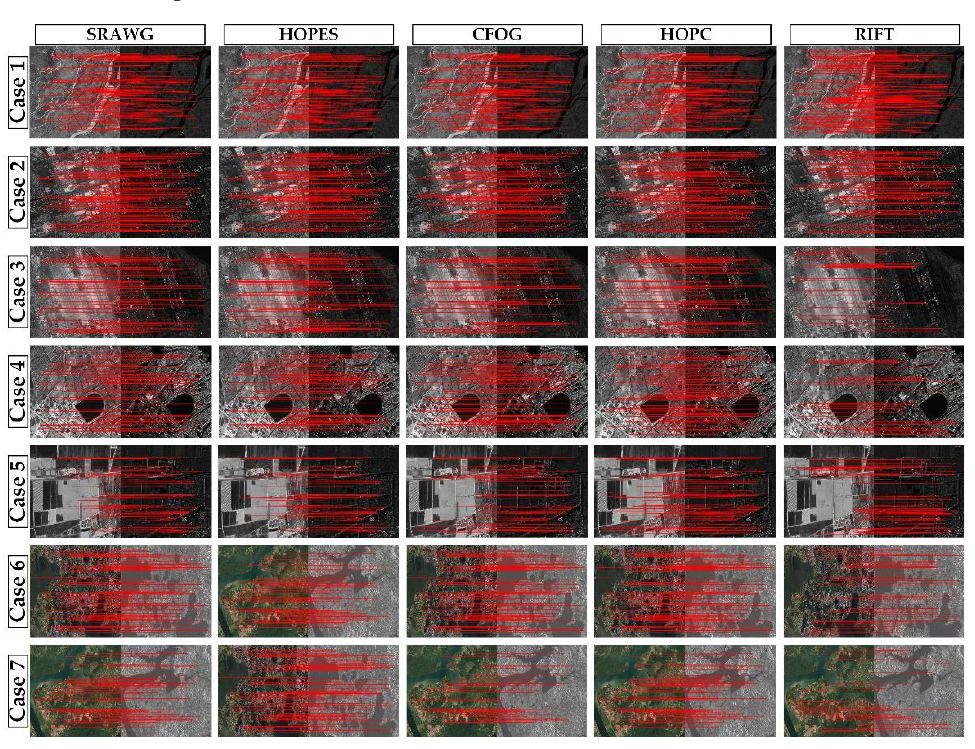
Figure 16. Registration results.